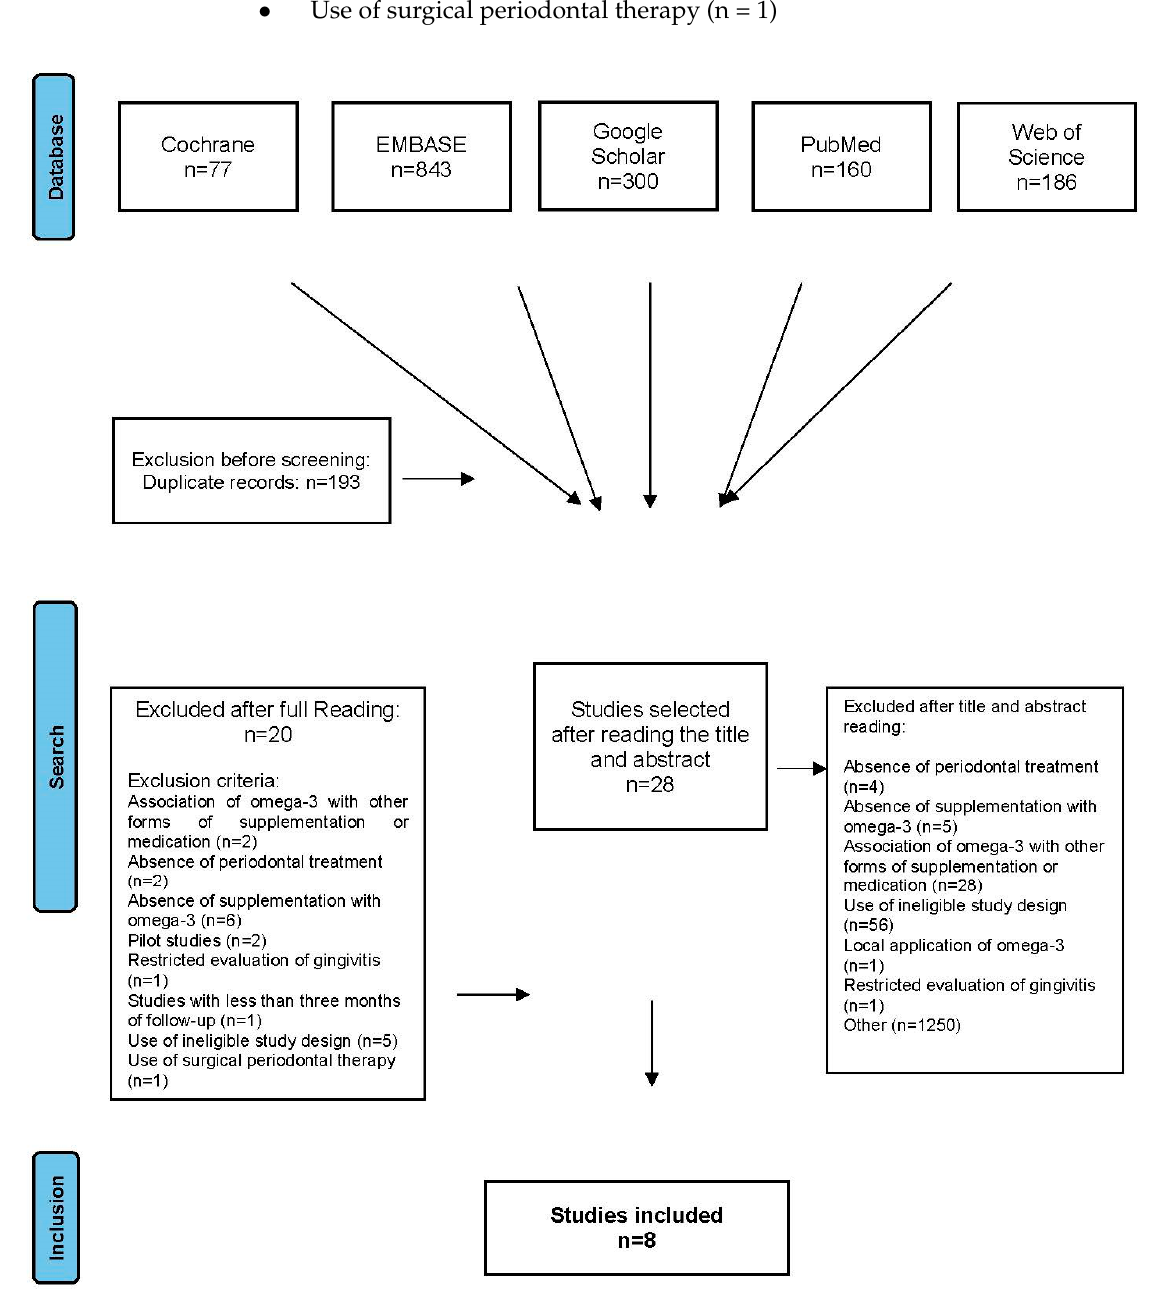
Figure 2. Flowchart of the process used to select studies for inclusion in the systematic review.